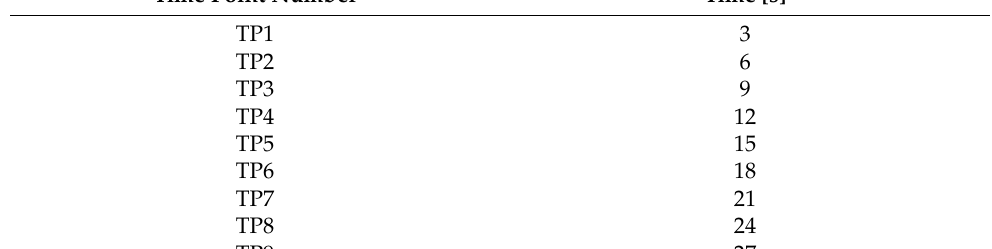
Figure 6. Mesh of the flow domain ( a ) the whole flow domain; ( b ) runner; ( c ) clearance between runner and head cover; ( d ) clearance between runner and bottom ring.